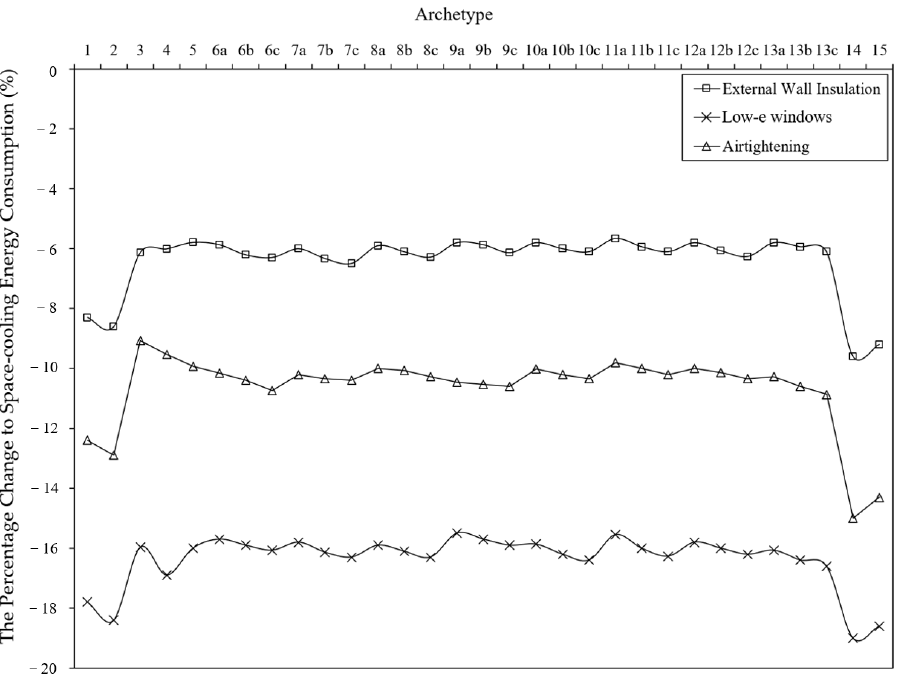
Figure 7. The percentage change to space-cooling energy consumption caused by individual fabric retrofits amongst the modelled archetypes (a: ground-floor flats, b: middle-floor flats, and c: top-floor flats), averaged over the pensioner and family results.